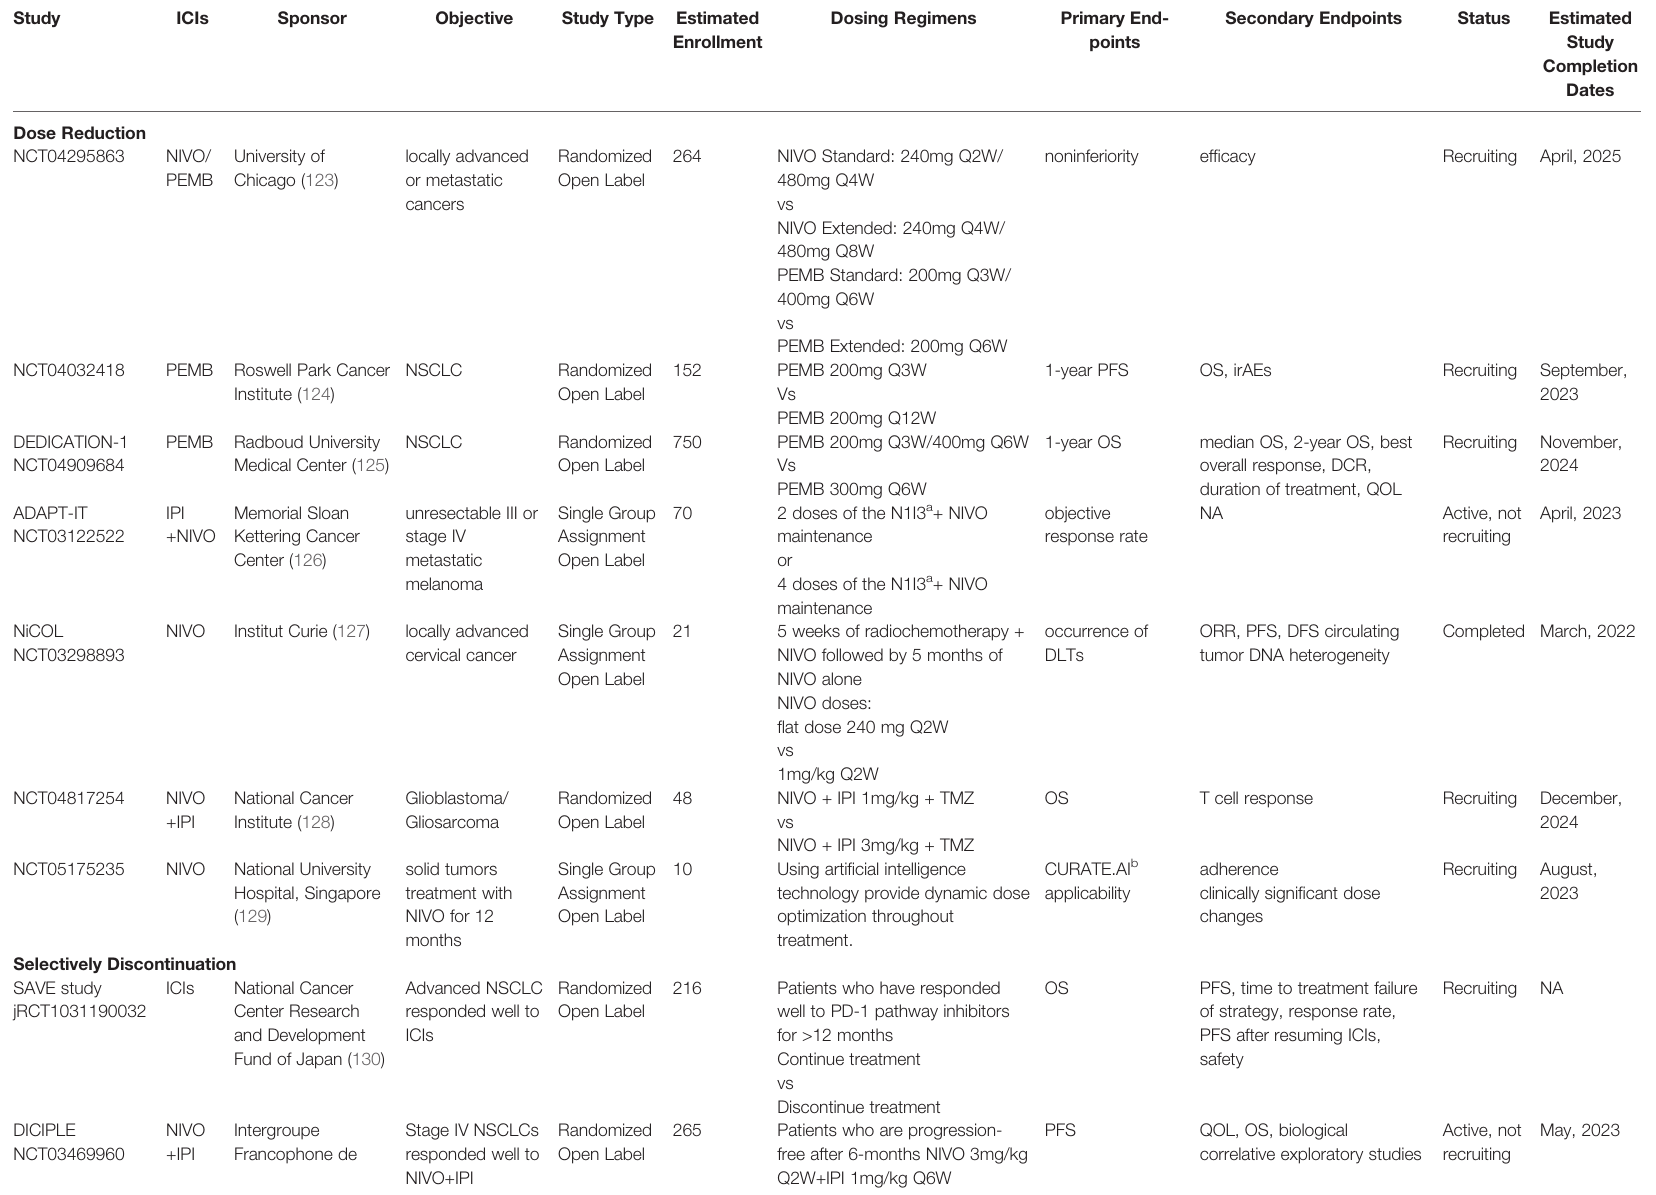
TABLE 3 | Ongoing clinical trials related to ICIs regimen optimization. (Comparing the modi fi ed dosing regimens with the standard dosing